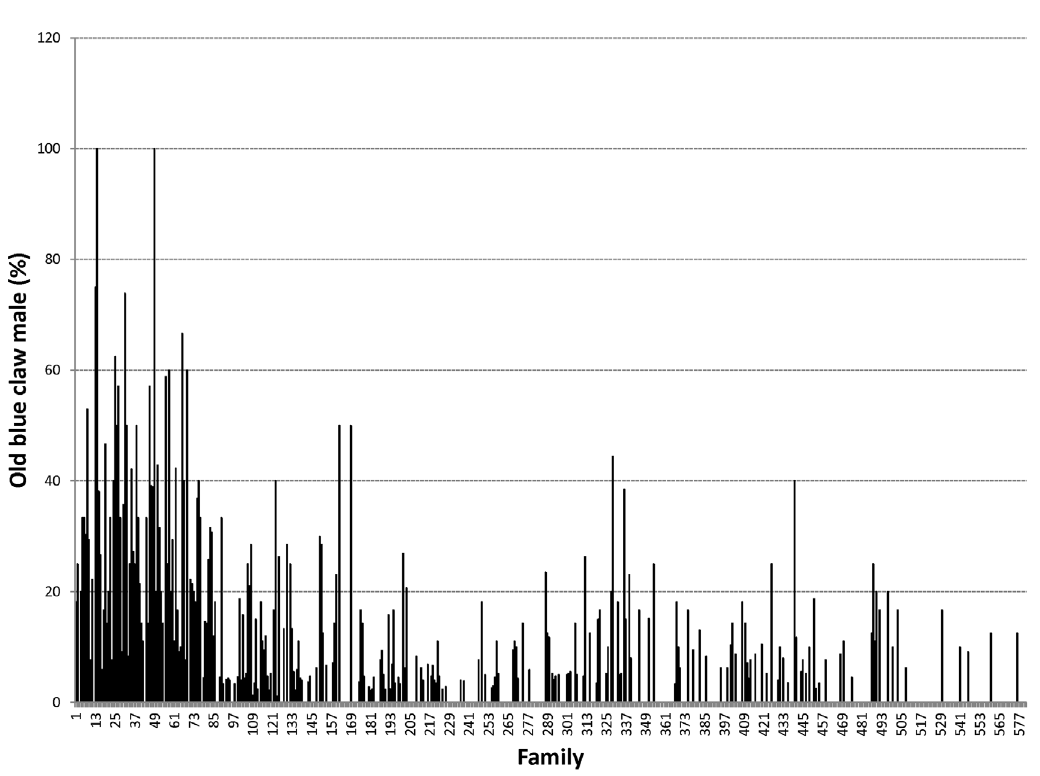
Figure 4. Old blue claw male. doi:10.1371/journal.pone.0090142.g004 PLOS ONE |